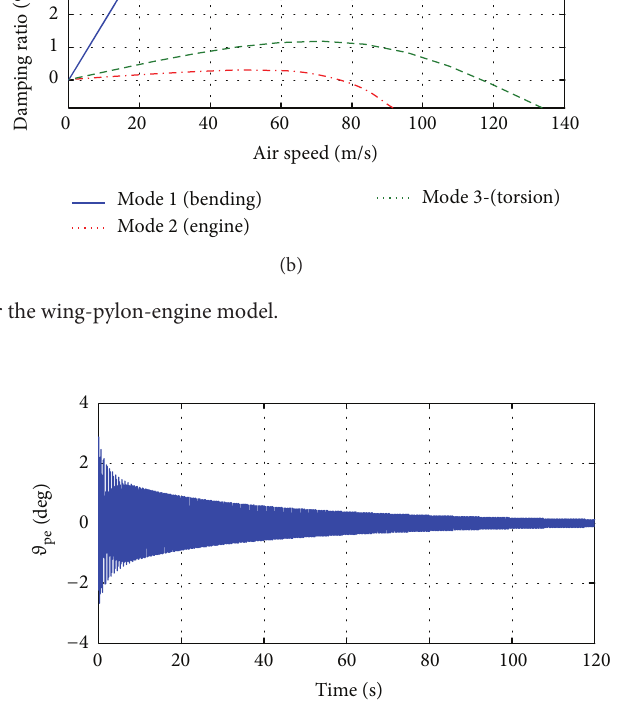
Figure 3: Steady-state LCO in 𝜗